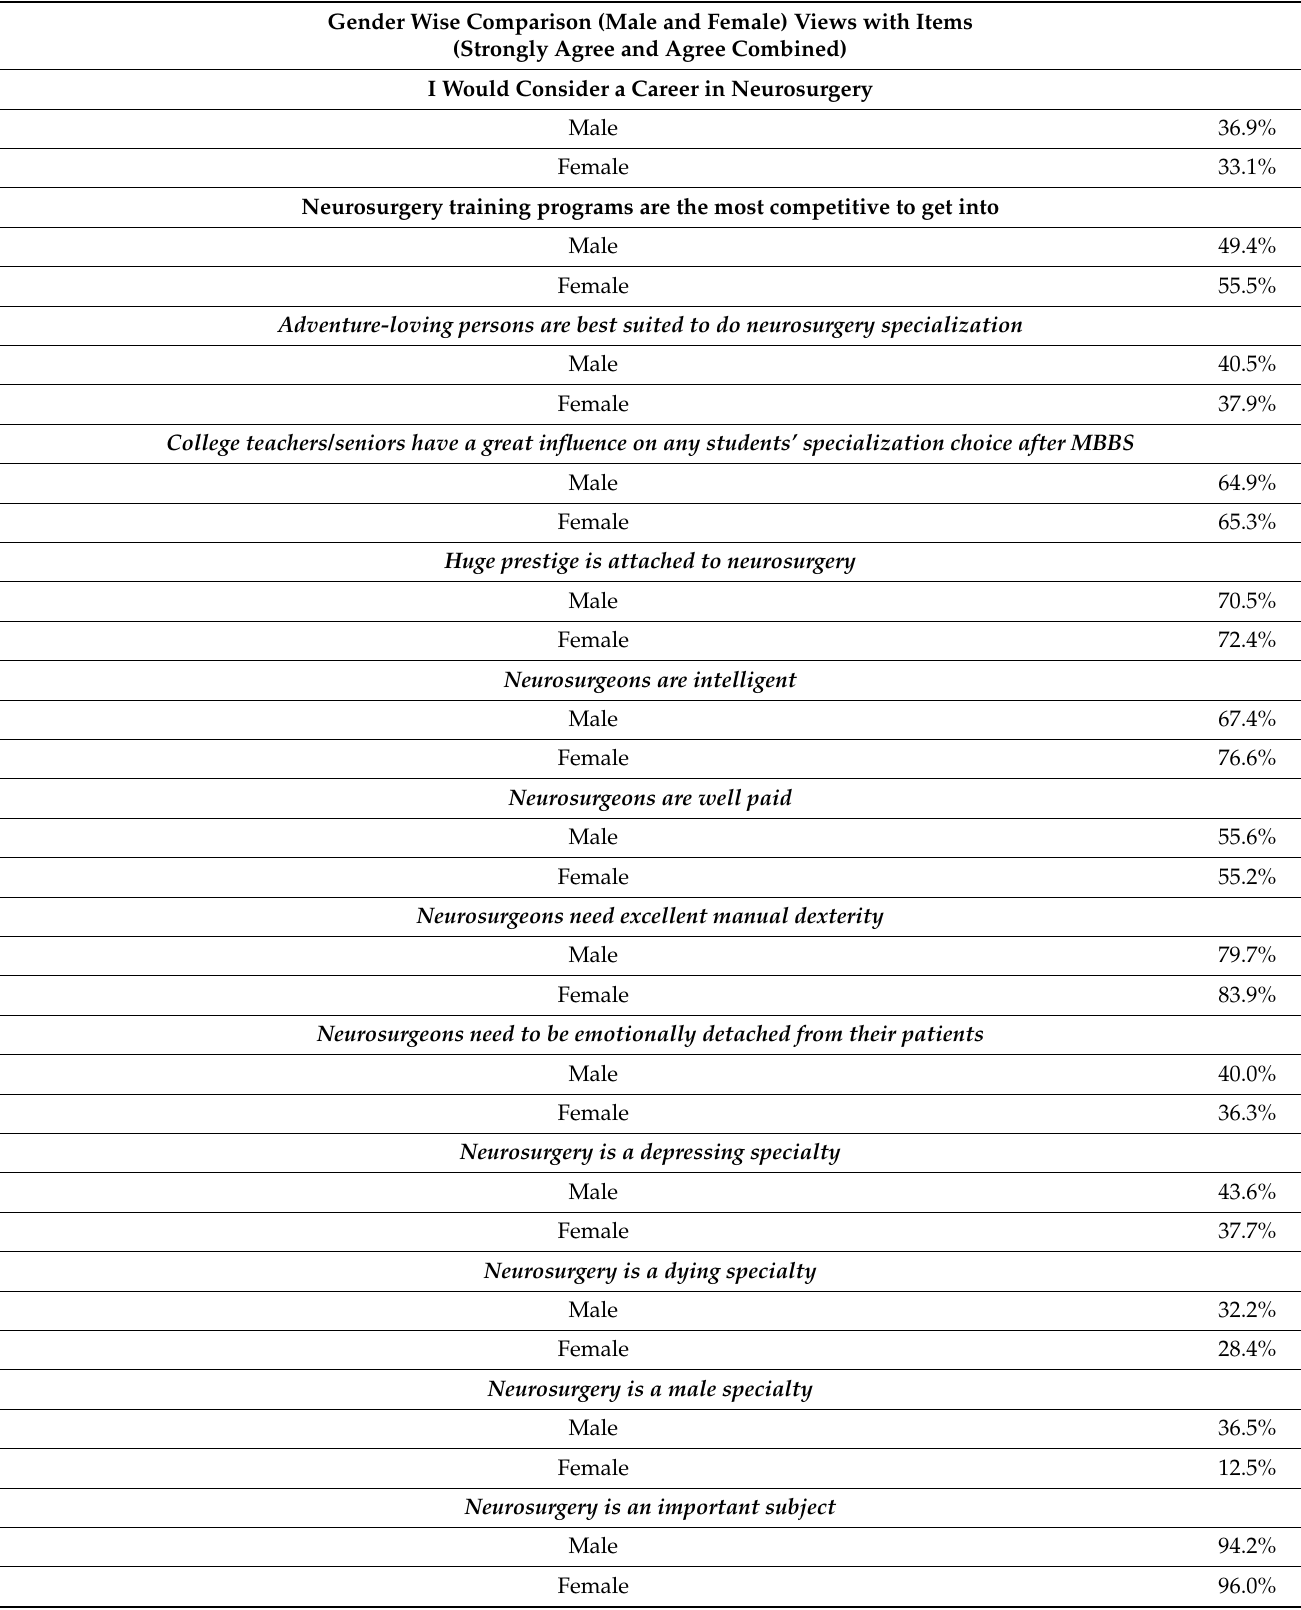
Table 4. Gender-wise comparison (male and female) views with items (strongly agree and agree